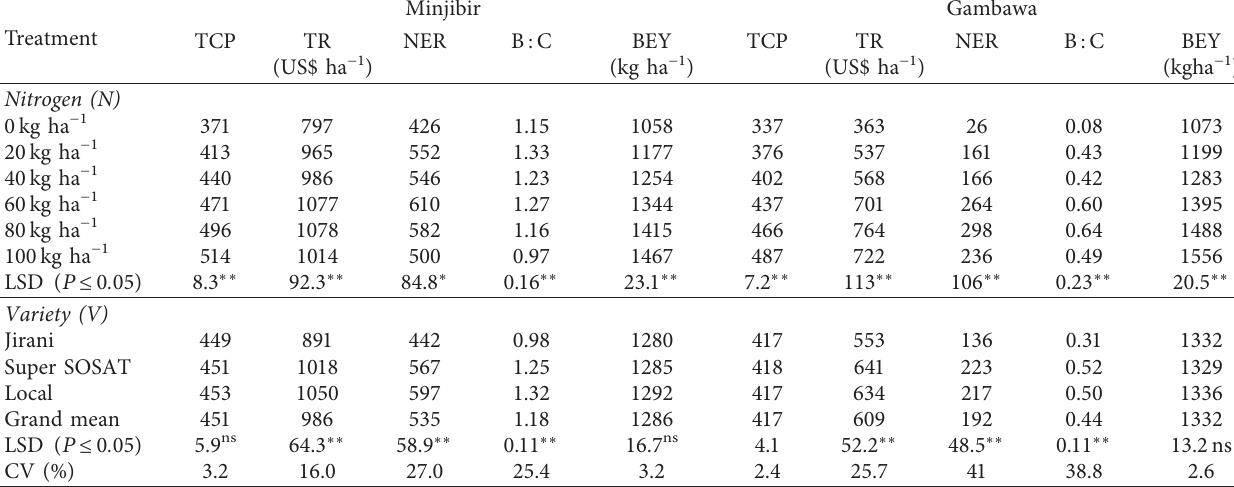
Table 4: Economic analysis of pearl millet varieties under N-fertilizer application in the semiarid zone of Nigeria (mean of 2014 and 2015 growing